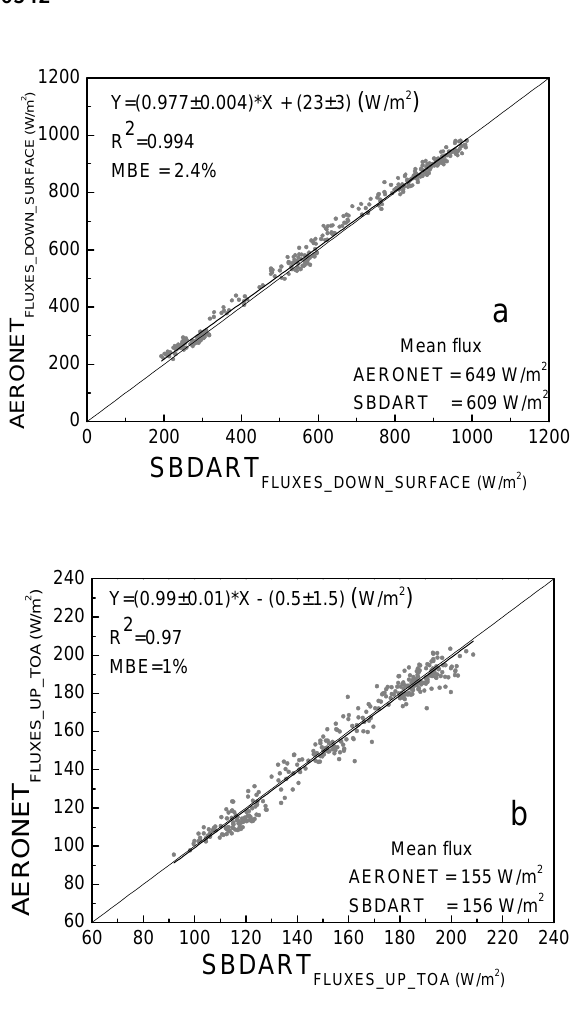
Fig. 6. Scatter plots of the instantaneous global irradiances using SBDART model against corresponding AERONET fluxes for (a) downward fluxes at surface and (b) upward fluxes at TOA. The black lines are the linear fits. The regression equations, determi- nation coefficients and biases are included in these figures.